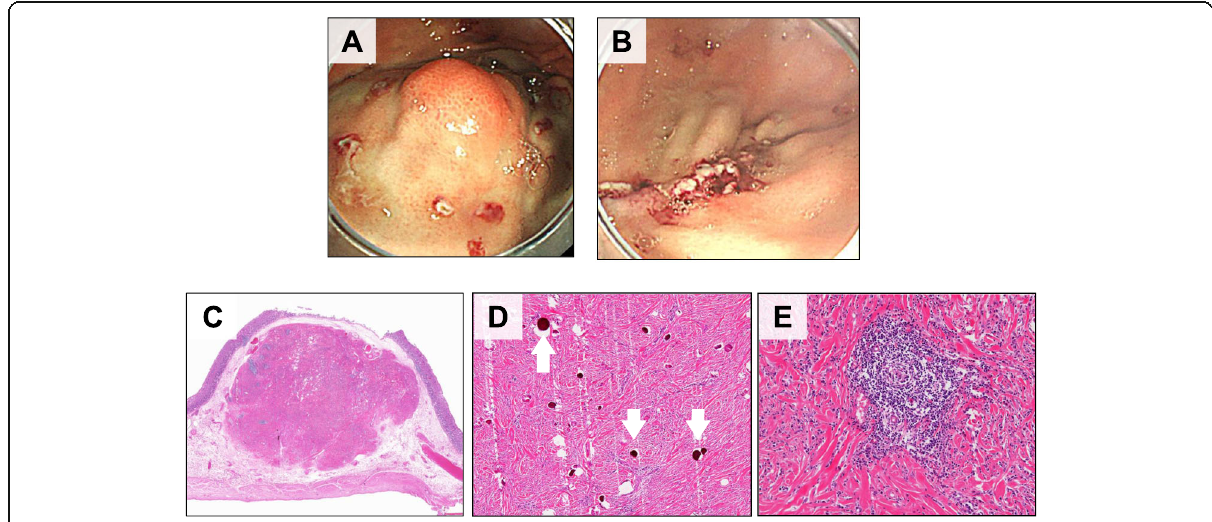
arrows), spindle cell proliferation with abundant hyalinized collagen, and infiltration of lymphoplasmacytic cells in the tumor ( e